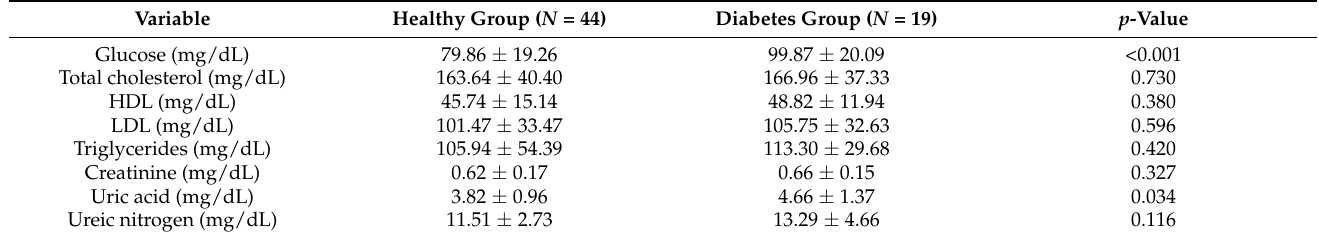
Table 2. Metabolic profile